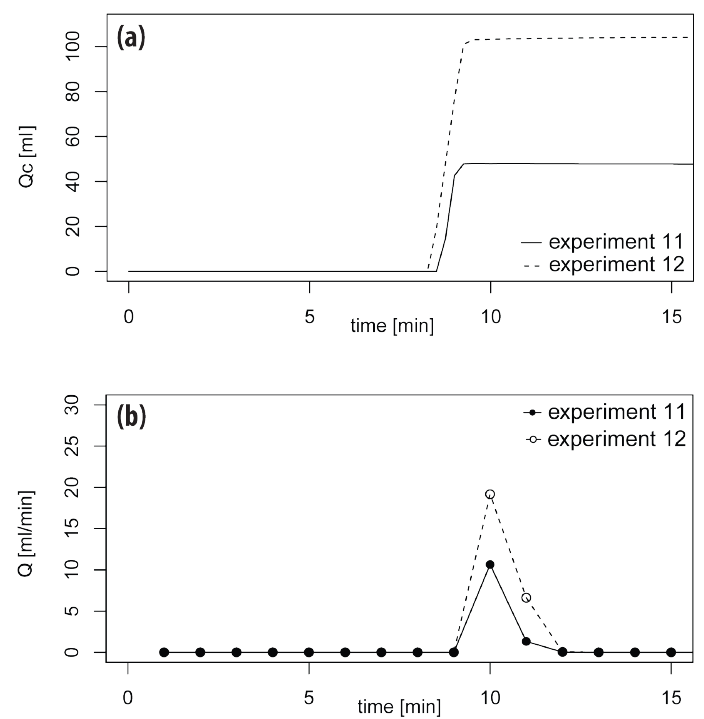
Figure 3. The influence of macropores on (cumulative) drainage for a soil column experiment with S90 sand. ( a ) compares cumulative drainage (Qc) for experiment 11 (no macropores) and experiment 12 (including macropores); and ( b ) compares drainage (Q) over time between experiment 11 (no macropores) and 12 (macropores). Note that the breakthrough curves start at approximately the same time and only the peak for a soil column including macropores is